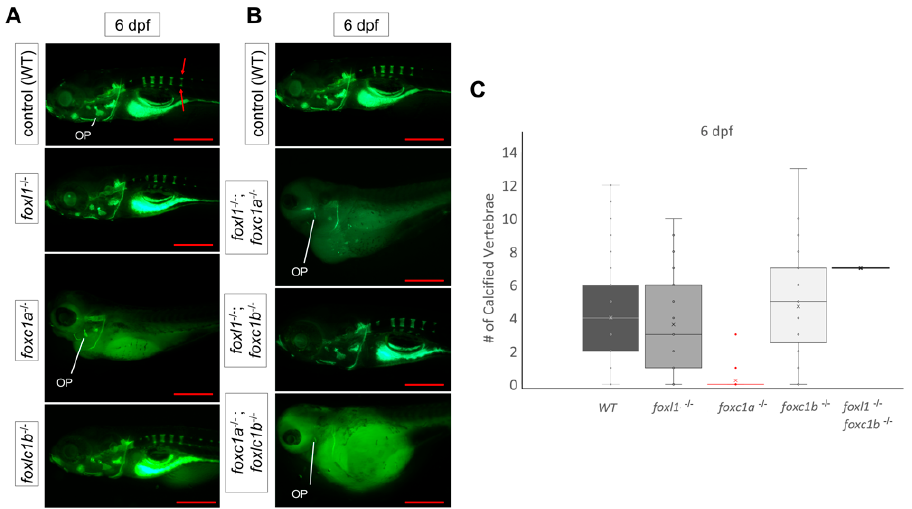
Figure 6. Calcein staining illustrating the impact of foxl1, foxc1a , and foxc1b lone and combined loss on axial skeleton development and calcification. ( A ) WT, foxl1 − / − , foxc1a − / − , and foxc1b − / − embryos at 6 dpf showing normal formation of the vertebrae in foxl1 and foxc1b mutants. foxc1a − / − embryos did not develop or calcify vertebrae and had large abdomen cavity edemas that grew over time. ( B ) WT; foxc1a − / − ; foxl1 − / − , foxc1b − / − ; foxl1 − / − , and foxc1a − / − ; foxc1b − / − embryos at 6 dpf. Double foxc1a − / − ; foxl1 − / − embryos exhibit larger edemas and a lack of most calcified structures at 6 dpf, including the operculum (OP). foxc1b − / − ; foxl1 − / − embryos had no significant change. foxc1a − / − ; foxc1b − / − mutants elicited similar results as foxc1a − / − ; foxl1 − / − embryos, including edemas and lack of craniofacial calcification. ( C ) Boxplots illustrating the variability in the number of vertebrae calcified in foxl1 − / − , foxc1a − / − , foxc1b − / − ,and foxl1 − / − ; foxc1b − / − mutants in comparison with WT embryos at 6 dpf. Red arrows indicate primary centres of ossification within the vertebrae. Scale bars are 500 µm.